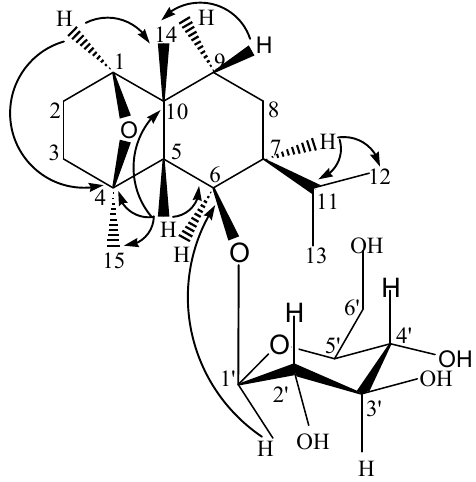
Figure 2. Key HMBC correlations of compound 3